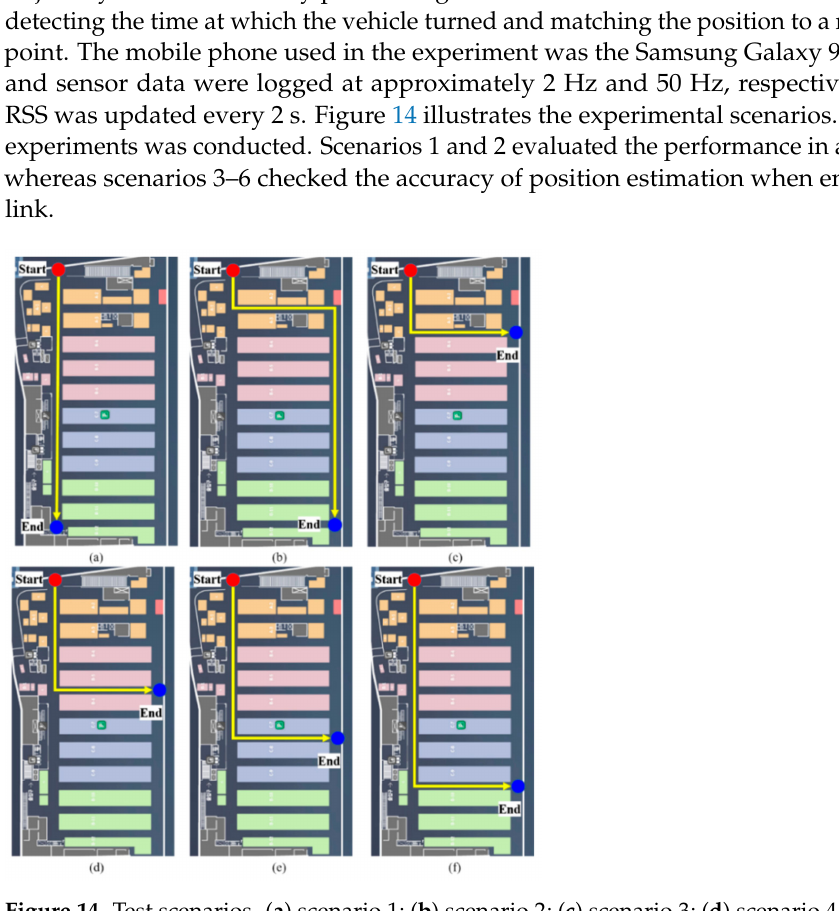
Figure 14. Test scenarios. ( a ) scenario 1; ( b ) scenario 2; ( c ) scenario 3; ( d ) scenario 4; ( e ) scenario 5; ( f ) scenario